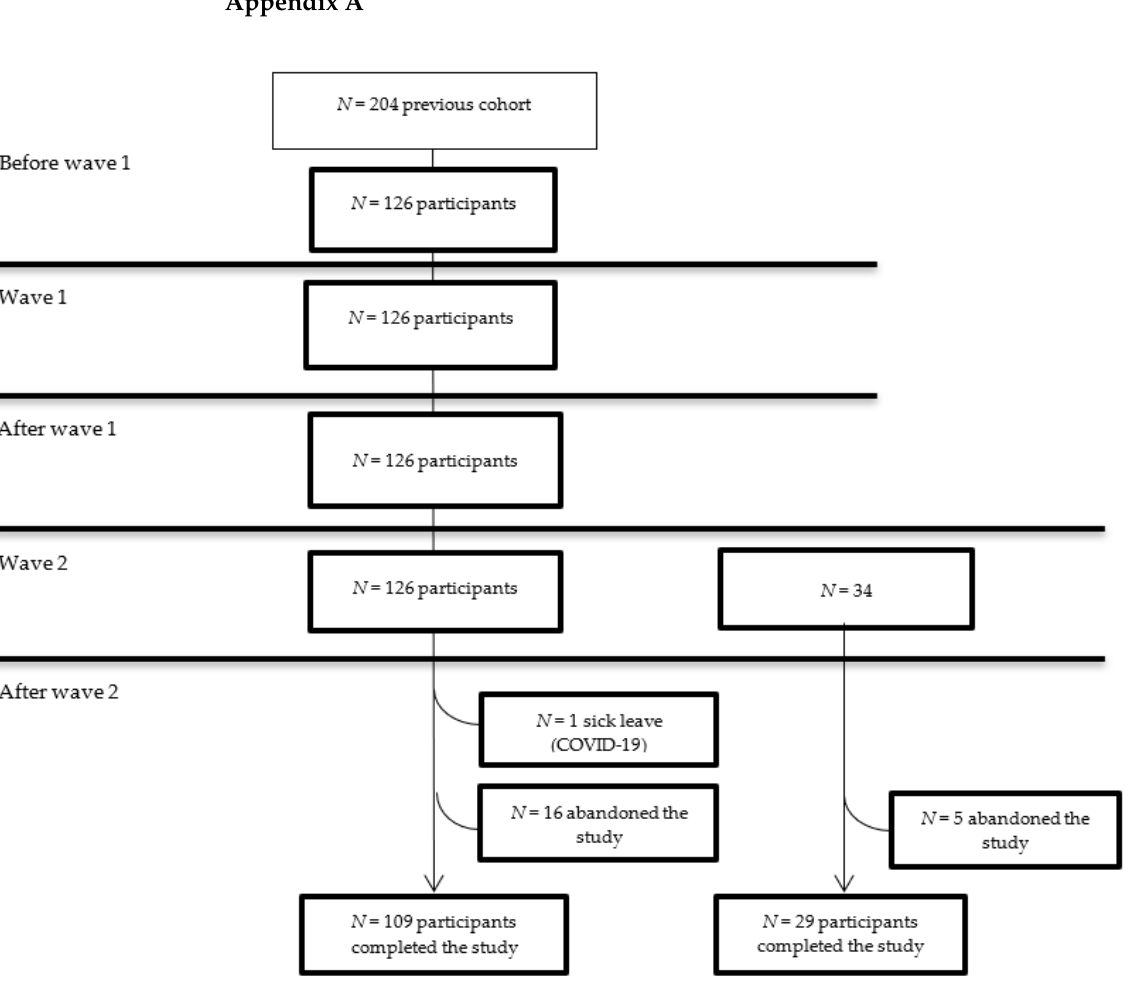
Figure A1. Number of participants during follow-up, according to the time of inclusion in the study, either at the first or the second epidemic wave.